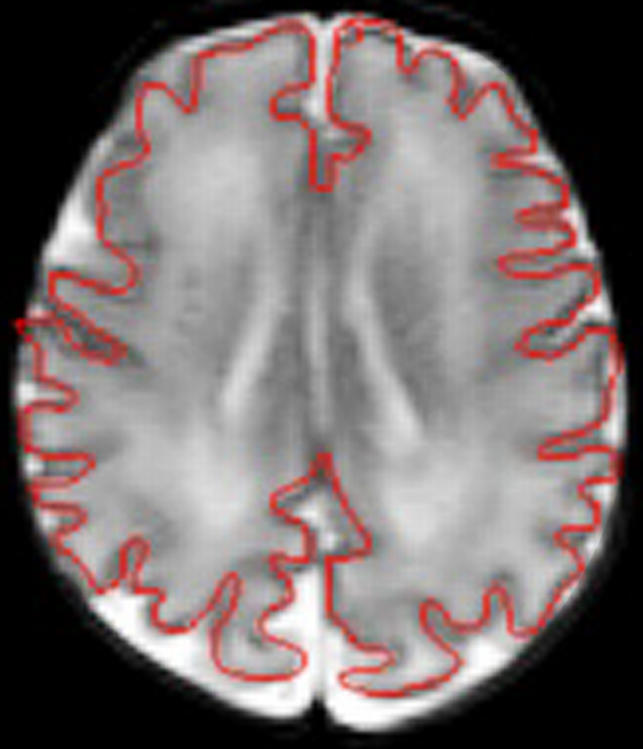
Annotated MR Image Showing Definition of Cortical Boundary